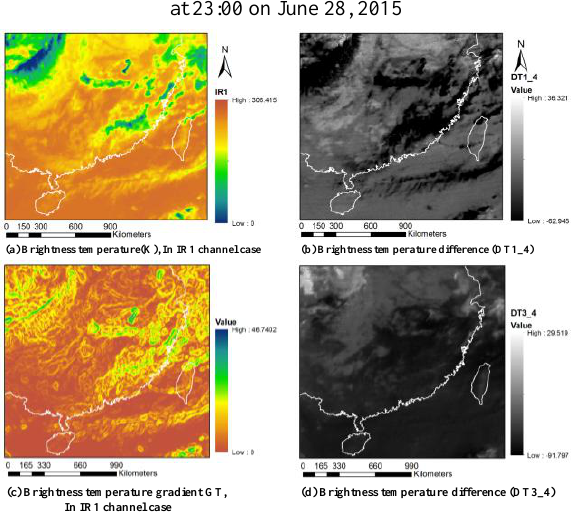
Figure 4. FY-2G parameters, including (a) brightness temperature, (b) channel 1 and Channel 4 brightness temperature difference, (c) brightness temperature gradient, (d) channel 3 and Channel 4 brightness temperature difference, at 23:00 on June 28, 2015